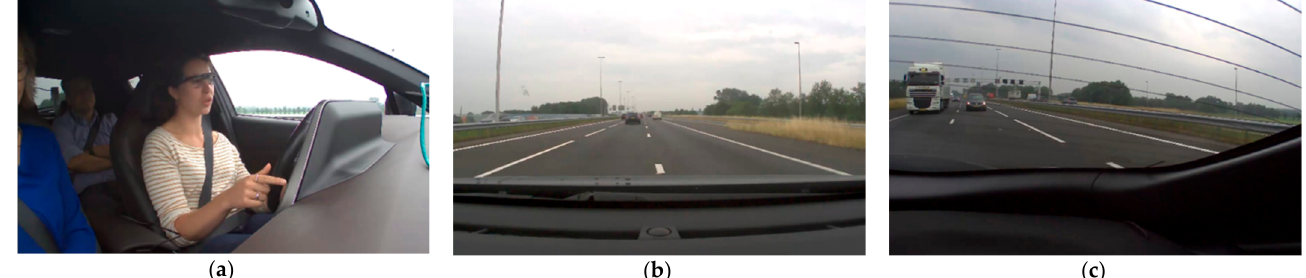
Figure 2. Examples of video images: ( a ) Interior view on driver; ( b ) Front view from behind windshield; ( c ) Rear-left view.